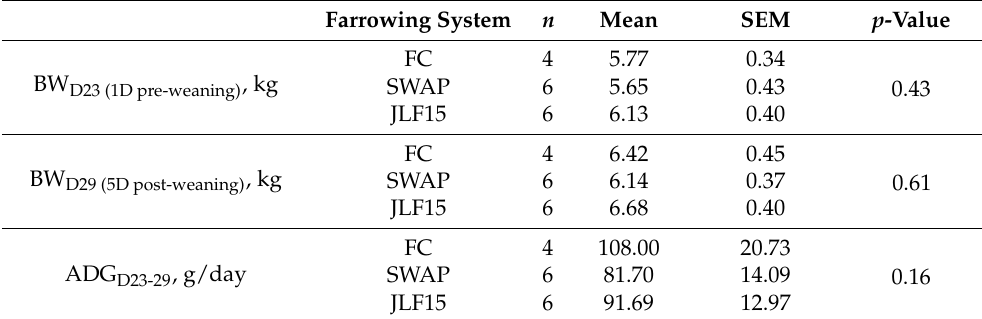
Table 6. Bodyweight (BW) (kg) on D23 (1D pre-weaning) and D29 (5D post-weaning), and average daily gain (ADG) (g/day) between D23 and D29 in piglets in three farrowing systems (FC: conven- tional farrowing crate; SWAP and JLF15: farrowing pens with temporary crating). n indicates the number of nursery pens.